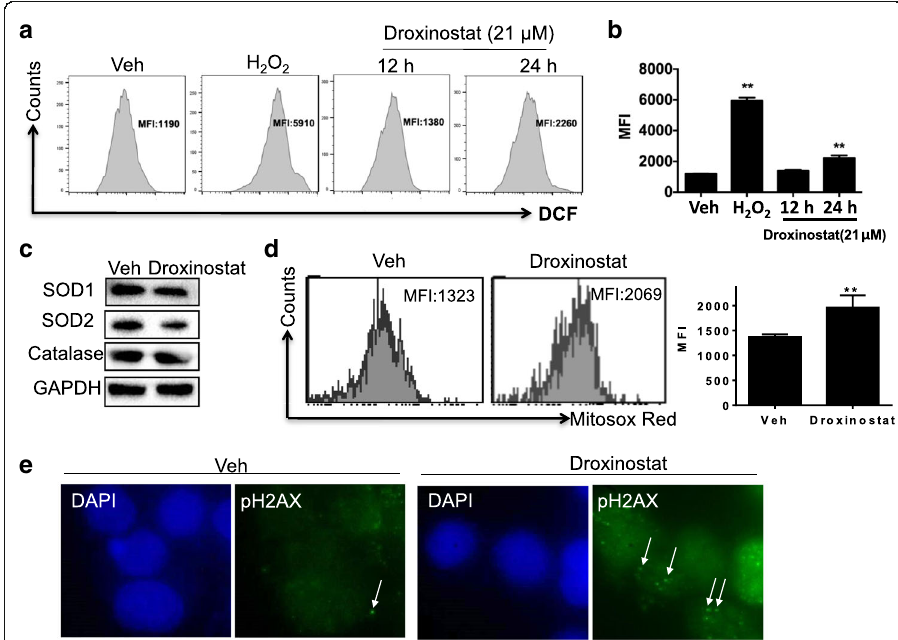
Fig. 3 Droxinostat induced oxidative stress in colon cancer cells. a and b – HT-29 cells were treated with droxinostat for 12 and 24 h. ROS production was measured using the probe DCFDA and analyzed via flow cytometry. The levels of ROS production are expressed as mean fluorescence intensity (MFI) and the means ± SD of three independent experiments. H 2 O 2 treatment was used as a positive control. c – HT-29 cells were incubated with droxinostat for 24 h. The expressions of SOD1, SOD2 and catalase were measured via western blot. GAPDH was used a loading control. d – HT-29 cells were incubated with MitoSOX Red 24 h after droxinostat treatment. Representative flow charts are shown, and the MFI is presented. e – phospho- Histone H2AX (pH2AX) staining was done 6 h after cells were incubated with droxinostat. DAPI was used to stain the nuclei. Representative pictures are shown (original magnification, 600×). ** p < 0.01 vs